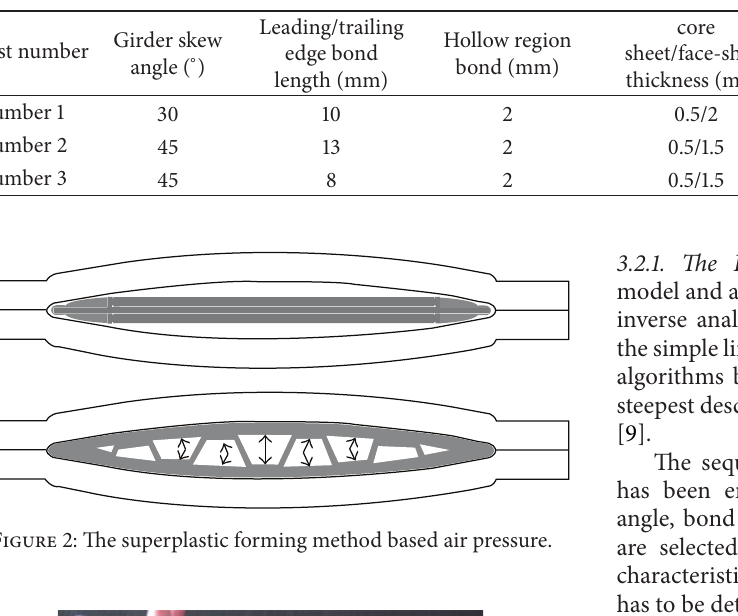
Figure 1: Geometric parameters of hollow structure. Table 1: Results of hollow panel impact tests.